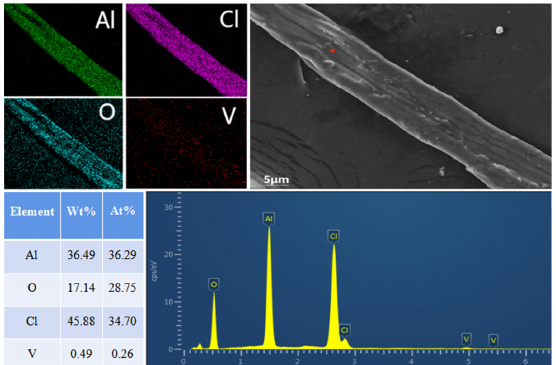
Figure 10. SEM–EDS characterization of fi brous substances formed during chlorination.